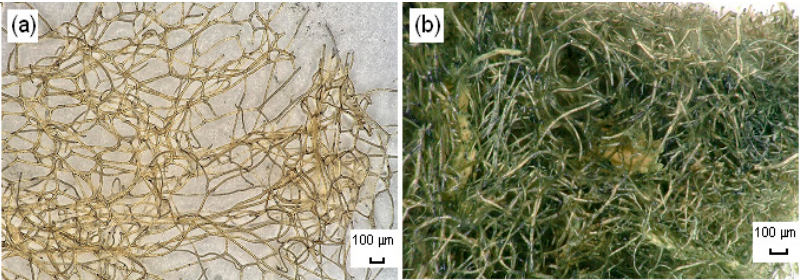
Figure 9. Light microscopy images of H. communis sponge skeletons before ( a ) and after ( b ) adsorption of SCC.